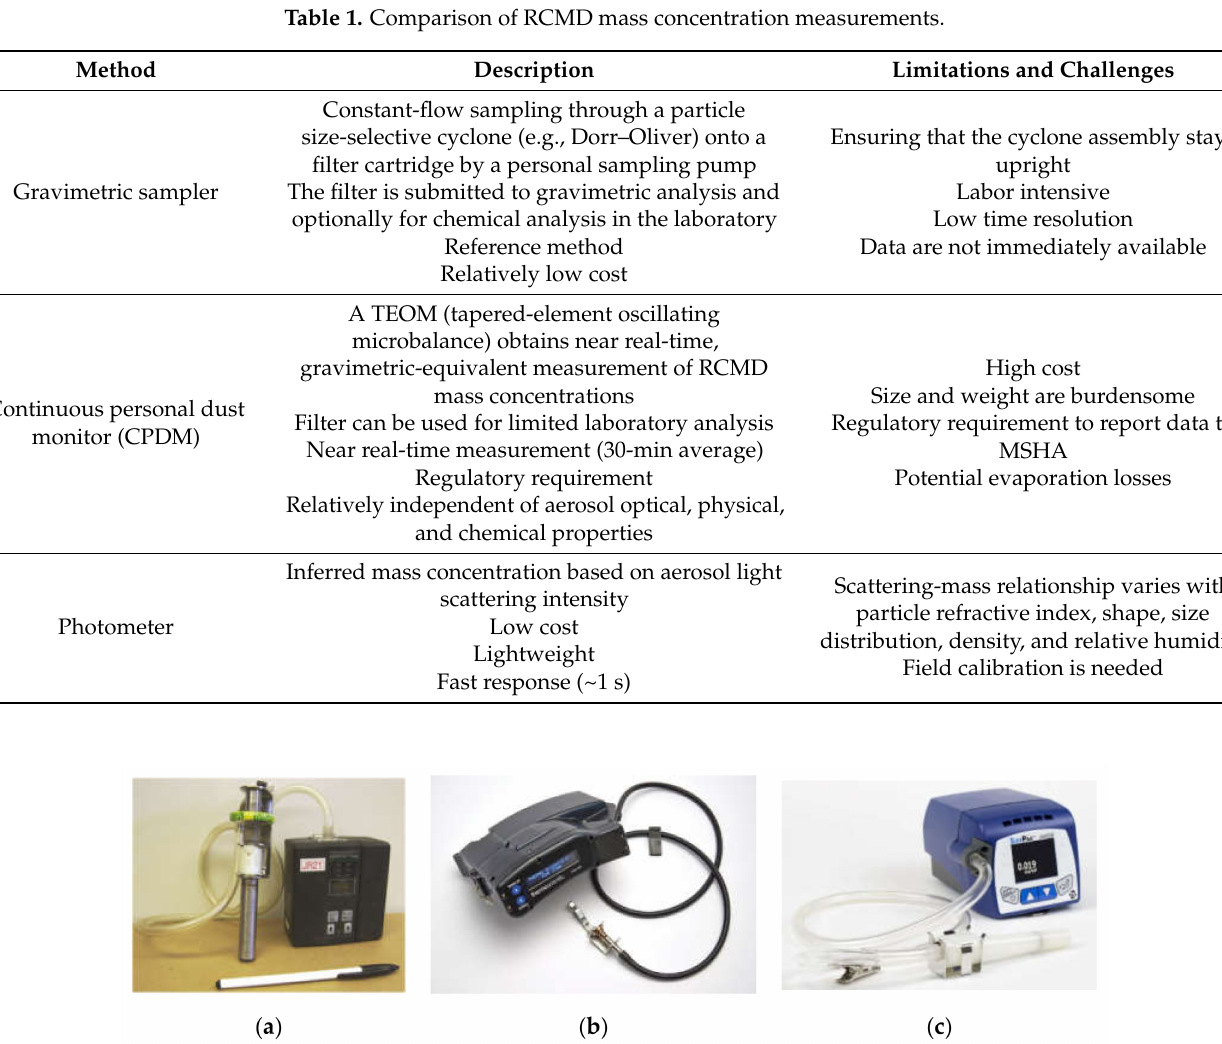
Figure 2. Examples of RCMD mass measurement devices: ( a ) a coal mine dust personal sampler unit (CMDPSU) with a sampling pump, cyclone, and filter cassette; ( b ) ThermoScientific Personal Dust Monitor (PDM) 3700; and ( c ) TSI SidePak photometer personal aerosol monitor (SidePak has not been approved by the MSHA [Mine Safety and Health Administration] for use in underground coal